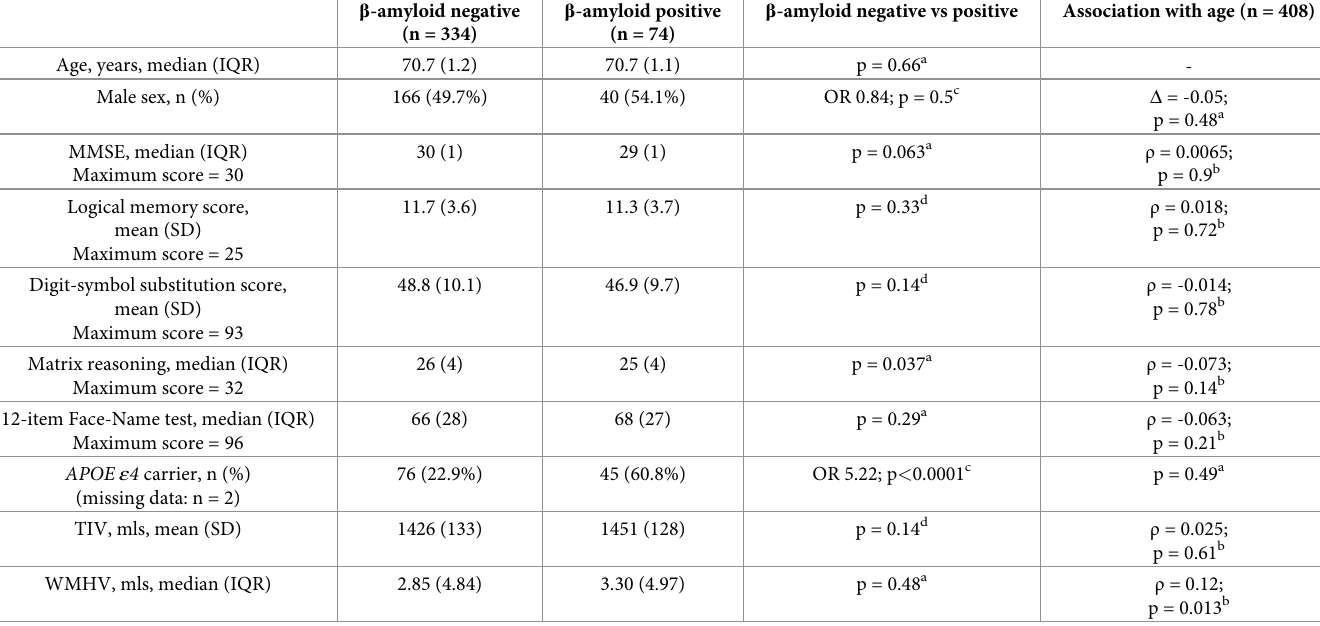
Table 1. Sample characterisation–unadjusted relationships between clinical, demographic and cognitive outcomes with β -amyloid positivity and age at time of scan. β -amyloid negative (n =